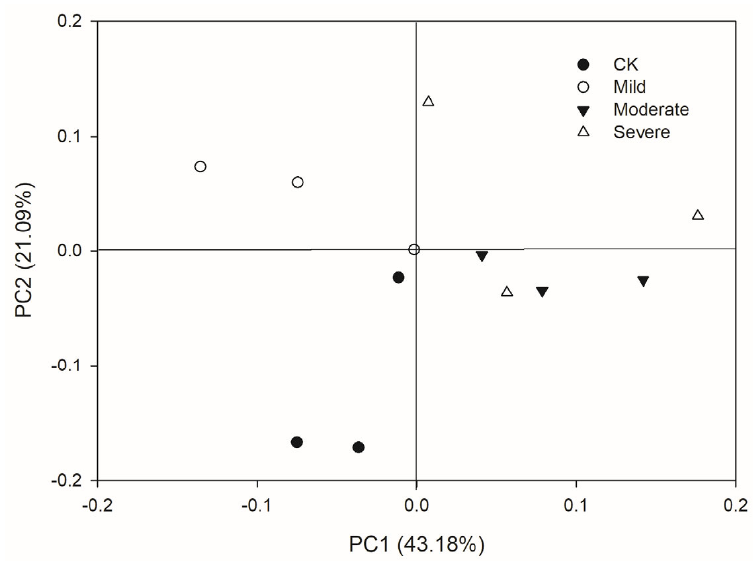
Figure 3. Effects of different levels of salt stress (CK, mild, moderate, and severe) on the endophytic fungal diversity of alfalfa, including the OTU number ( a ), Shannon–Wiener index ( b ), Simpson in ‐ dex ( c ), ACE ( d ), and Chao 1 estimator ( e ). Values are means ± SEs. Significant differences between different levels of salt stress are indicated by uppercase letters ( p < 0.05).